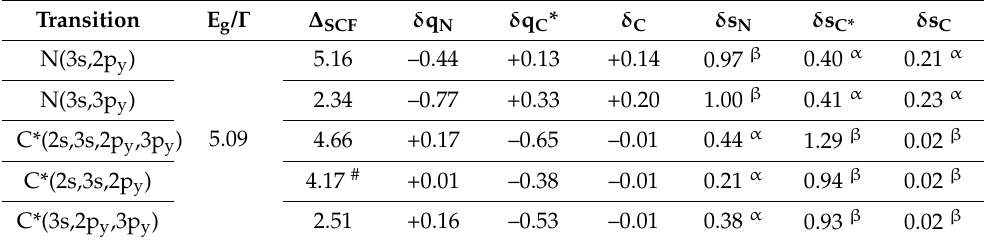
Table 6. N s+ B3LYP/6-21G Γ -point gap (E g /E Γ ) and direct SCF energy ( ∆ SCF ) (eV) and changes to atomic charges ( | e | ), δ q N , δ q C* , δ q C , atomic spins ( | e | ), δ s N , δ s C* , δ s C , in N s+ . α and β refer to changes in spin-up and spin-down orbitals charges and spins, respectively.